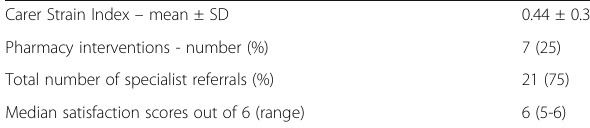
Table 3 (abstract 000057). Other